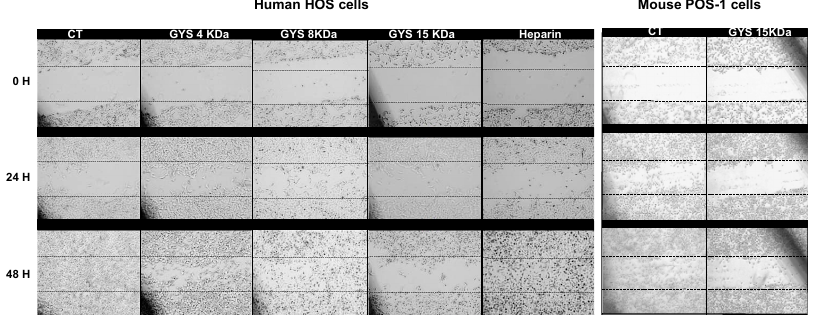
Figure 2. Migration of the human HOS cells and mouse POS-1 cells in the presence of various OS-EPS derivatives (300 µg/mL): OS-EPS 15 kDa (GYS15), OS-EPS 8 kDa (GYS8), OS-EPS 4 kDa (GYS4), heparin